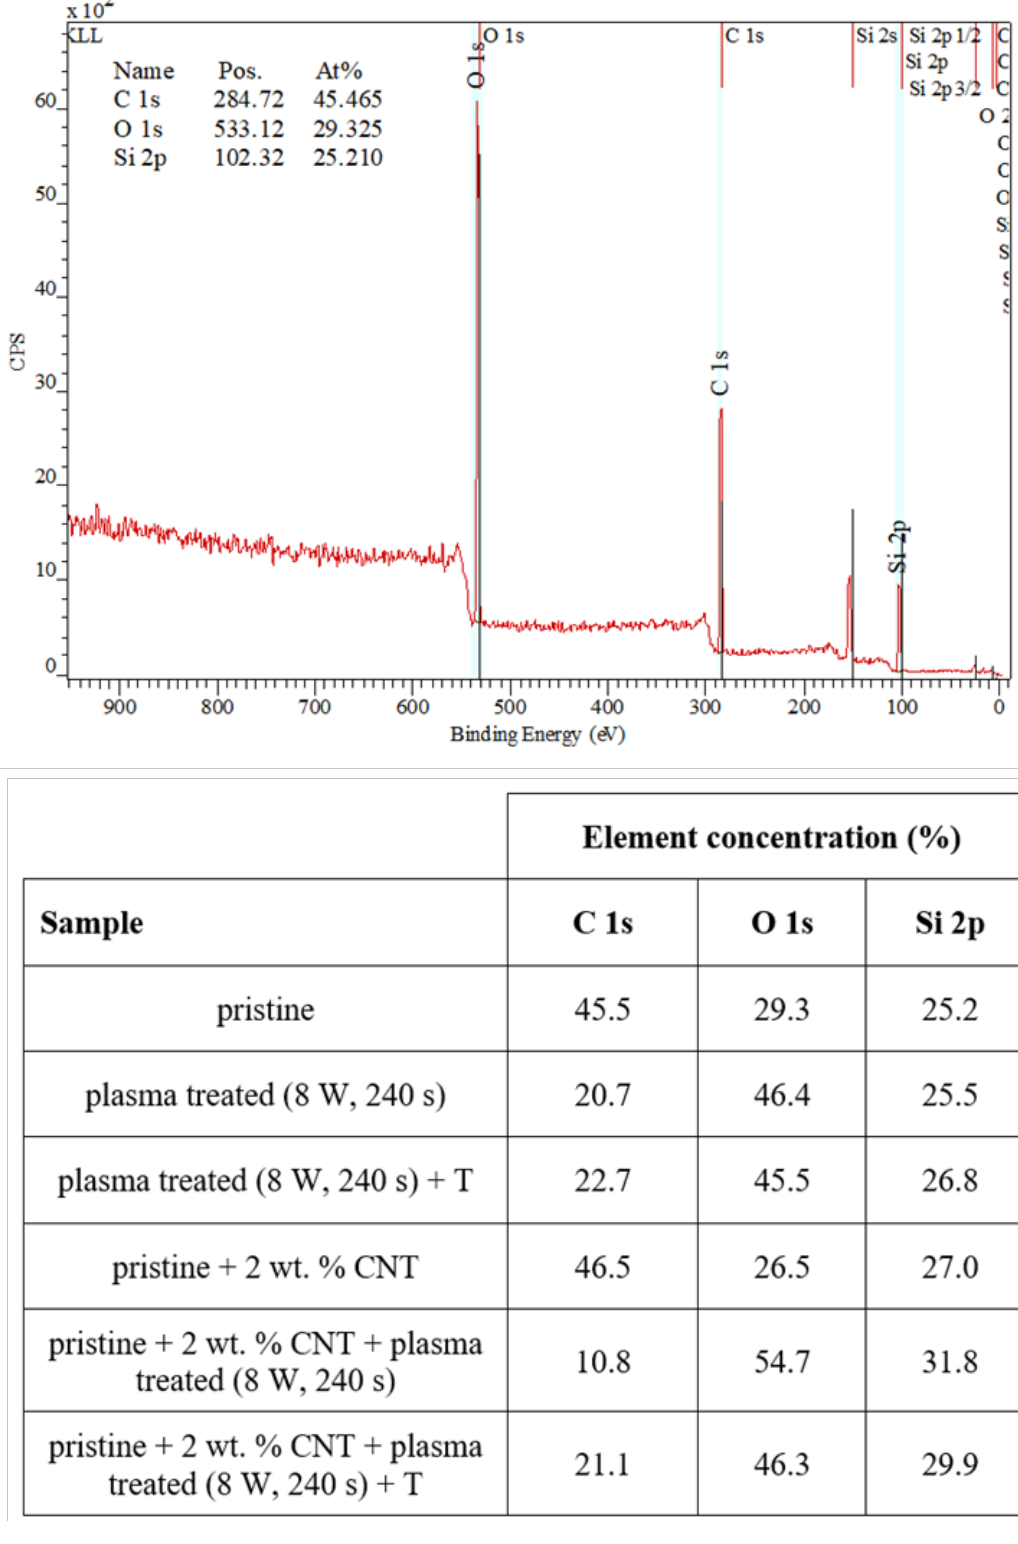
Figure 5. XPS spectrum of a pristine PDMS foil and changes in concentration of the monitored elements on measured pristine, doped, plasma-treated (8 W and 240 s), and heated PDMS samples (100 °C, 1 h).